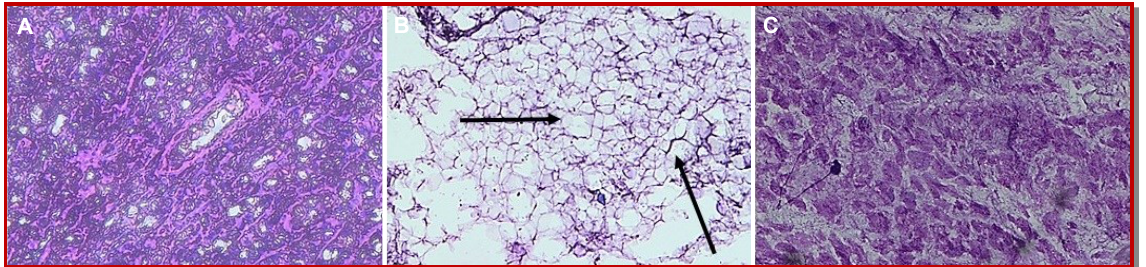
Figure 2: Histological observation of pancreas in streptozotocin-nicotinamide type-2 diabetic rat. ‘A’ represents the control group; ‘B’ represents the streptozotocin -nicotinamide- treated pancreas showing the formation of necrosis as presented by arrows; ‘C’ represents the A. wallichii extract (400 mg/kg)-treated group showing the reversal of pancreas